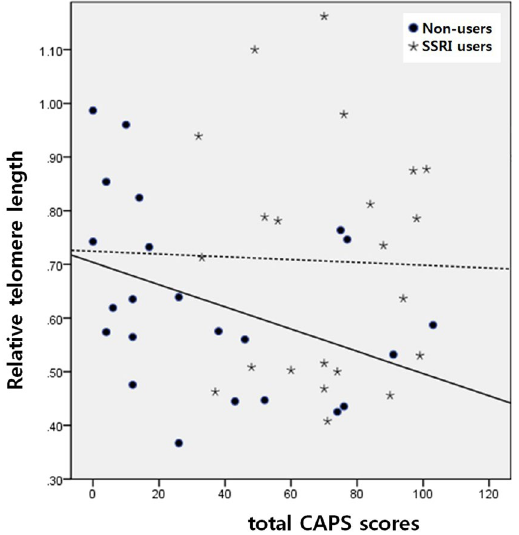
Figure 2. Partial correlation between relative telomere length and PTSD symptom scores within SSRI non- users ( n = 23) or within SSRI users ( n = 22) among veterans exposed to a severe level of trauma ( n =